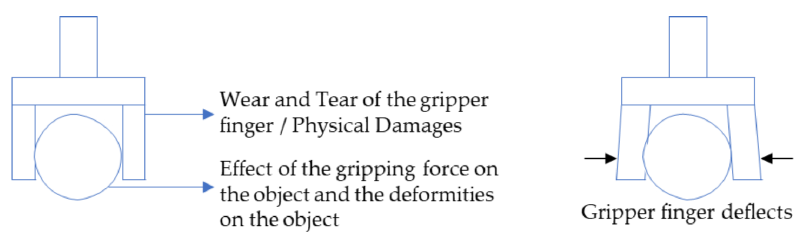
Figure 12. The complexity of modelling DT in robotics. It is still uncertain how DT can exactly represent a real-world process such as wear and tear, physical damages, object deformities, object slip and deflection of gripper